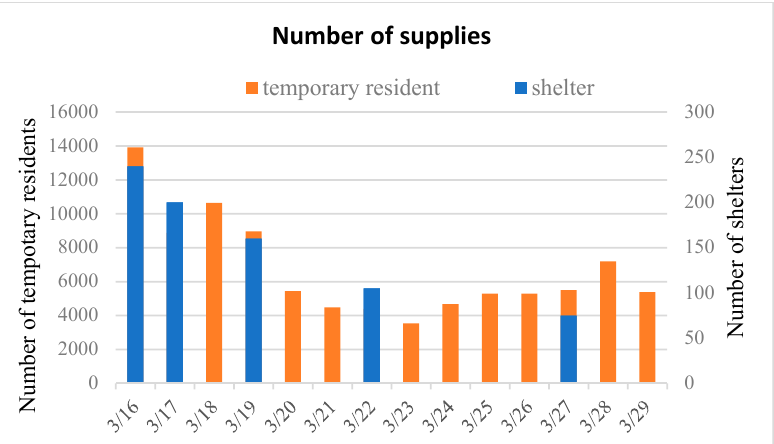
Figure 6. Number of temporary shelters and residents. Figure 5. Supply of other goods. Figure 5. Supply of other goods.